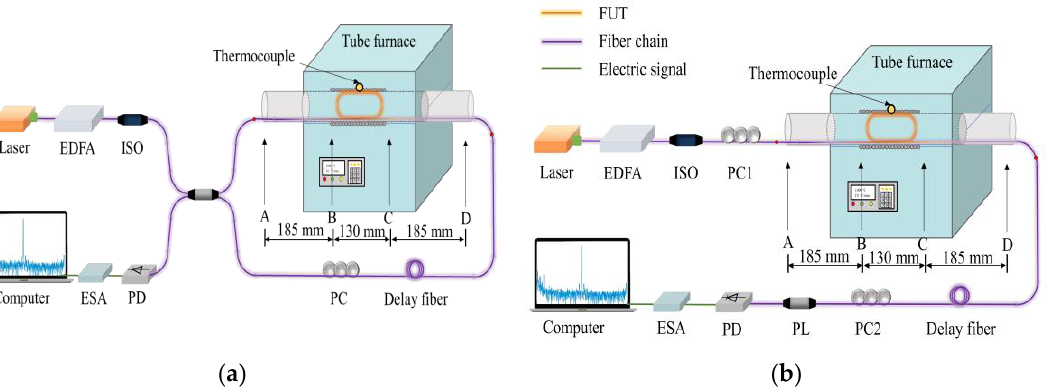
Figure 1. Schematic setup of the high temperature sensing system based on ( a ) polarized GAWBS, and ( b ) depolarized GAWBS. EDFA, erbium-doped fiber amplifier; ISO, isolator; PC, polarization controller; FUT, fiber under test; PL, polarizer; PD, photo detector; ESA, electrical spectrum analyzer.